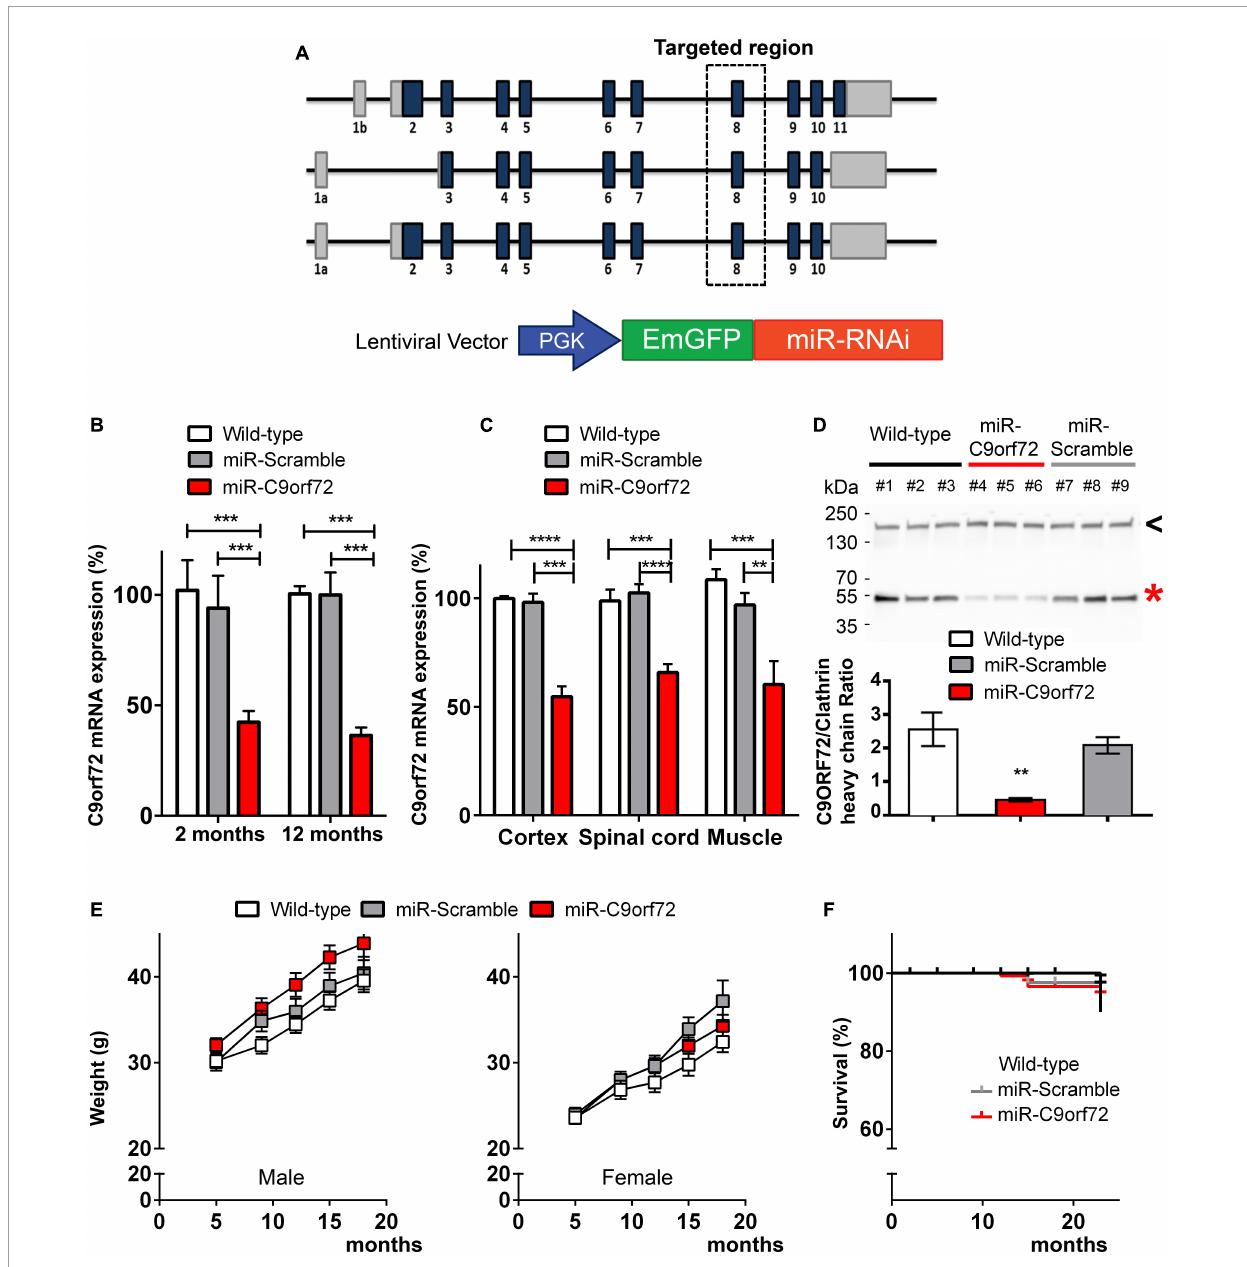
FIGURE1 Generation of C9ORF72 knockdown mice. (A) Schematic representation of C9orf72 transcripts in the mouse and the lentiviral vector used to perform transgenesis. MiR-C9orf72 targeted region is denoted by a square zone. (B) Relative expression of C9orf72 mRNA in transgenic mice cortex, at 2 and 12 months measured by qPCR. (wild-type n = 3; miR-Scramble n = 3, c9 n = 6). (C) Relative expression of C9orf72 mRNA in transgenic mice cortex, spinal cord, and muscle measured by qPCR at 23 months (wild-type n = 10; miR-Scramble n = 12, c9 n = 34). (D) Levels of mouse C9ORF72 protein orthoog in the cortex of miR-C9orf72, miR-Scramble, and wild-type mice. The expression of C9ORF72 (red asterisk) was quantified by densitometric analysis of western blots and normalized to clathrin heavy chain (black arrowhead). The positions of the molecular weight marker are indicated on the left in kDa. (E) Weight curve of males (left) and females (right) miR-C9orf72 mice compared to controls (wild-type n = 10; miR-Scramble n = 12, miR-C9orf72 n = 34). (F) Survival curve of C9ORF72 deficient and control animals up to 24 months (wild-type n = 10; miR-Scramble n = 12, miR-C9orf72 n = 34). Error bars represent SEM; * p < 0.05, ** p < 0.01, *** p < 0.001, **** p <